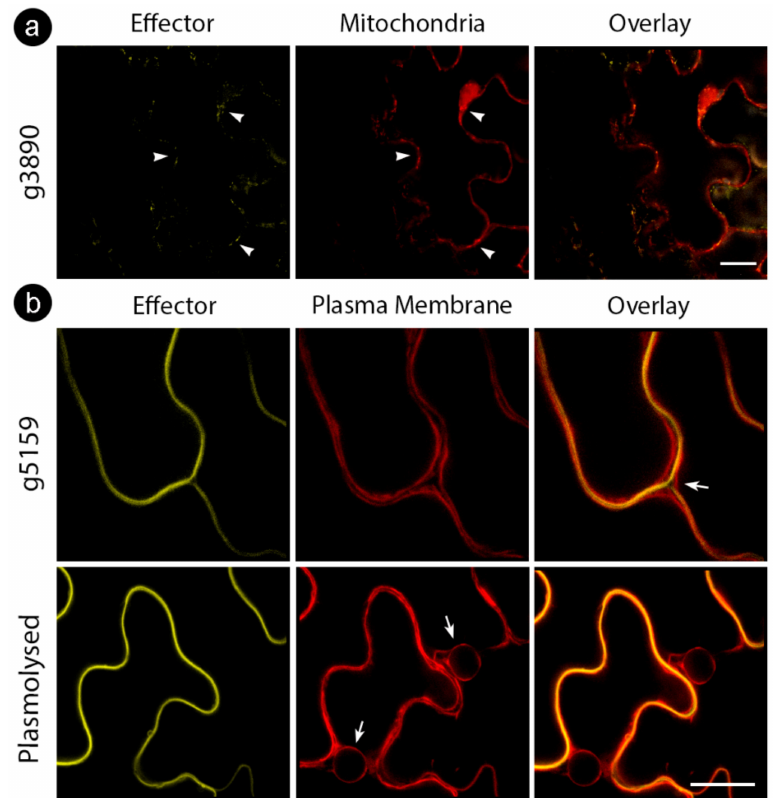
Figure 3. Cellular markers co-infiltrated with S. scitamineum candidate e ff ector proteins. ( a ) g3890 co-infiltrated with mitochondrial marker, showing colocalization (white arrowheads) ( b ) g5159 co-infiltrated with plasma membrane marker before (upper row) and after (bottom row) plasmolysis with 0.5M NaCl. Note the localization of e ff ector fusion protein between plasma membranes of adjacent cells (white arrow, upper row) and plasma membrane regression after plasmolysis (white arrows, bottom row). Bars: 20 µ